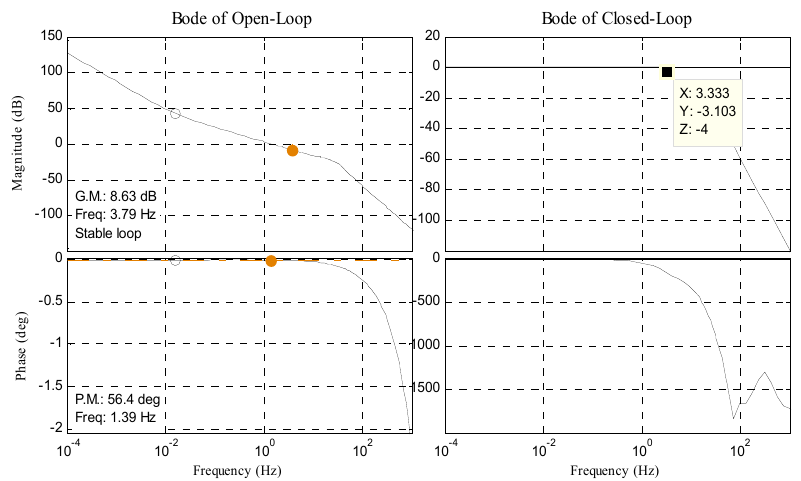
Figure 4. Bode diagram of open position-loop and closed position-loop in delay situation.